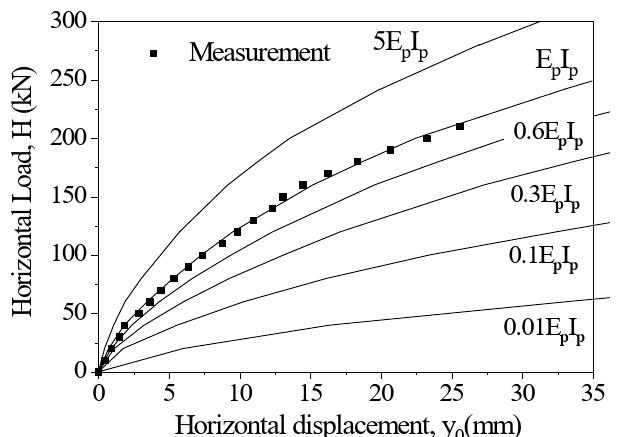
Figure 9. Response of steel H-section pile HS1 embedded in Area A, for various bending stiffness